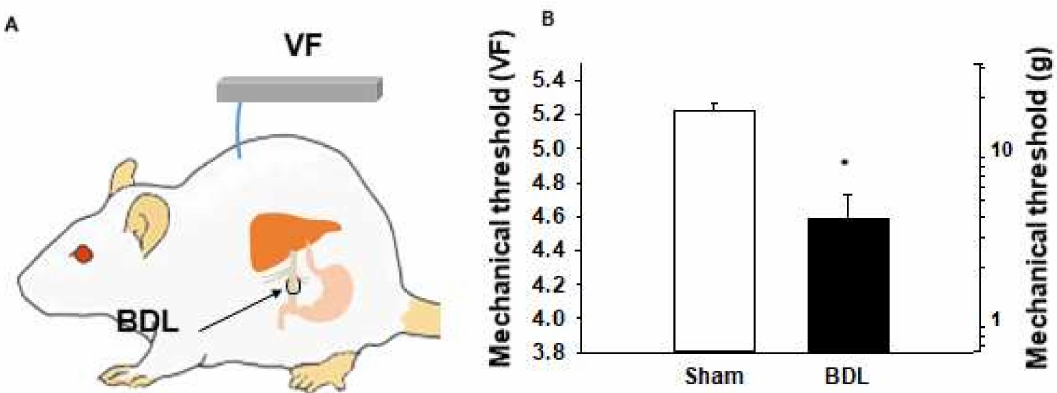
Figure 2. Increased mechanical sensitivity at the dorsal trunk in BDL rats. ( A ). Mechanical threshold was measured at the dorsal trunk by von Frey filaments (VF). ( B ). Comparison of mechanical sensitivity at the dorsal trunk in BDL ( n = 7) or sham ( n = 5) operated rats. * p < 0.05 vs. Sham. BDL, bile duct